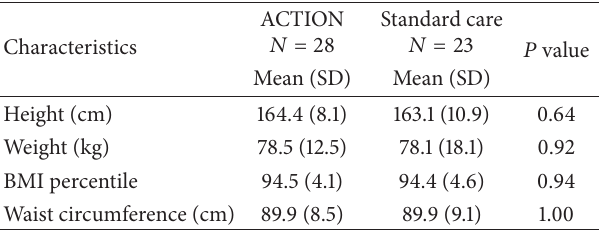
Table 3: Anthropometric measurements of ACTION and standard care groups at